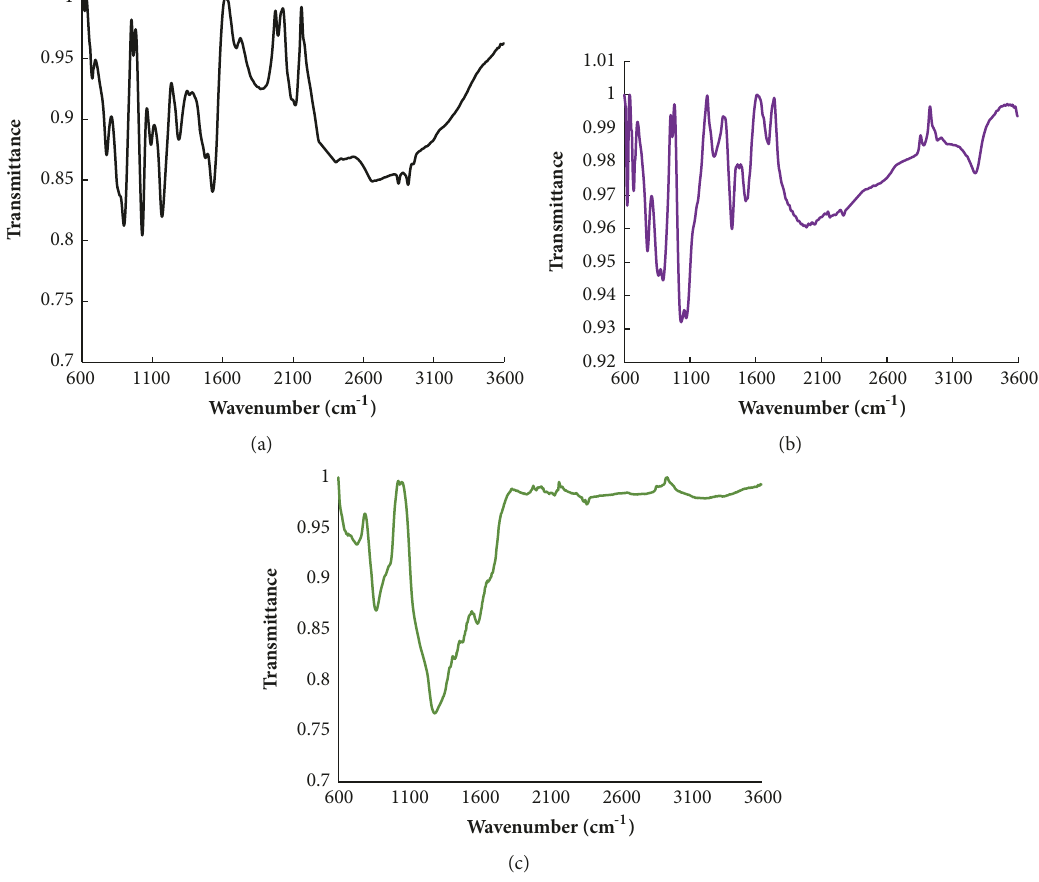
Figure 3: FTIR spectra of (a) NIP film, (b) MIP film, and (c) overoxidized MIP film.